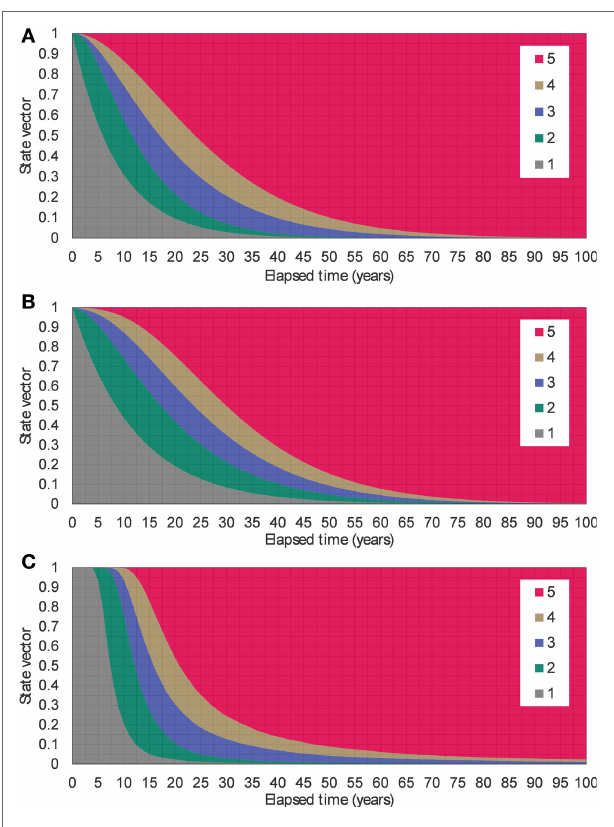
FIGURE 3 | Transition of state vector over time: (A) calculated using the transition probabilities estimated by the proposed methodology; (B) calculated using the transition probabilities estimated by the state-of-the-art methodology; and (C) calculated using the mechanistic-empirical models.